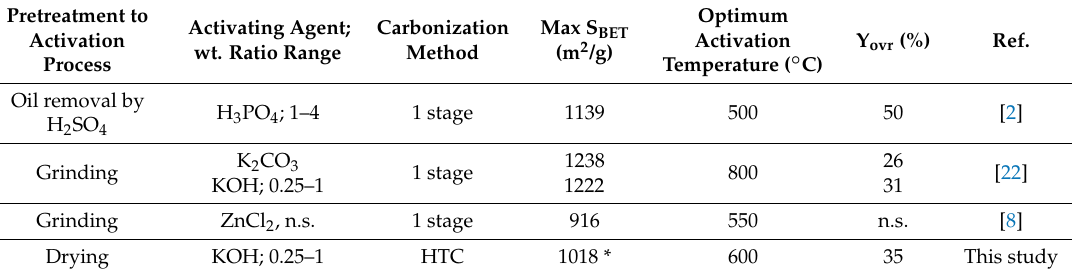
Table 4. Comparison of grape seeds activated carbon properties of the “optimum samples” from a selection of